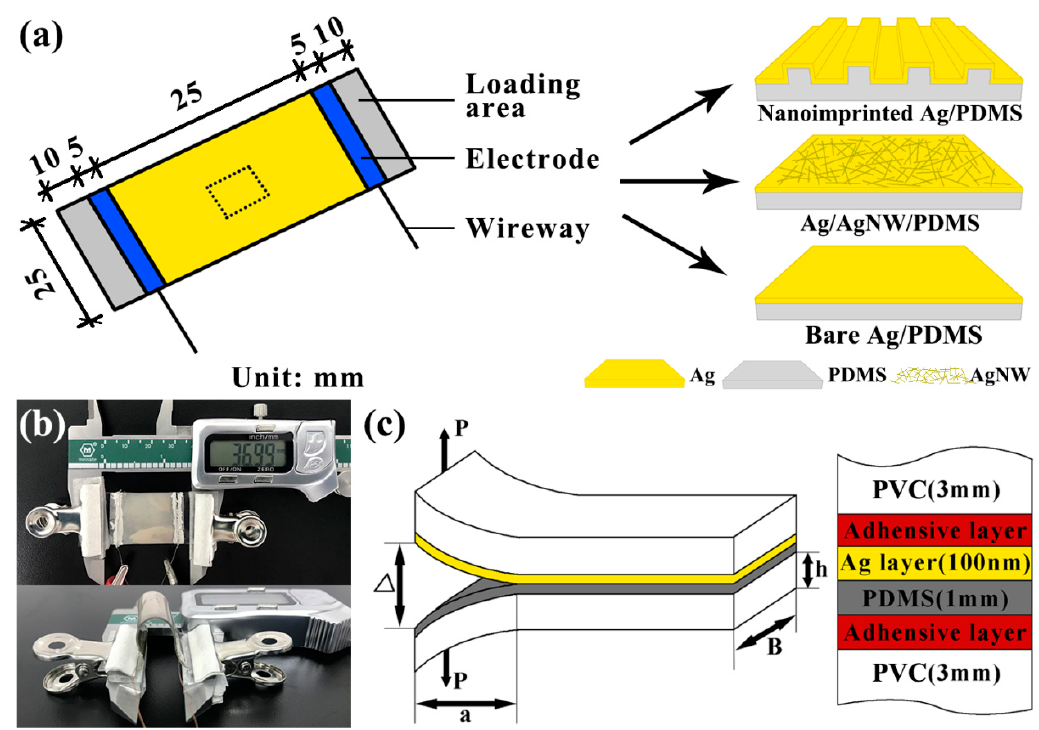
Figure 1. ( a ) Schematic diagram of fabricated samples. ( b ) Photograph of the experimental setup for measuring the ∆ R / R 0 . ( c ) Schematic diagram of double cantilever beam (DCB) test.